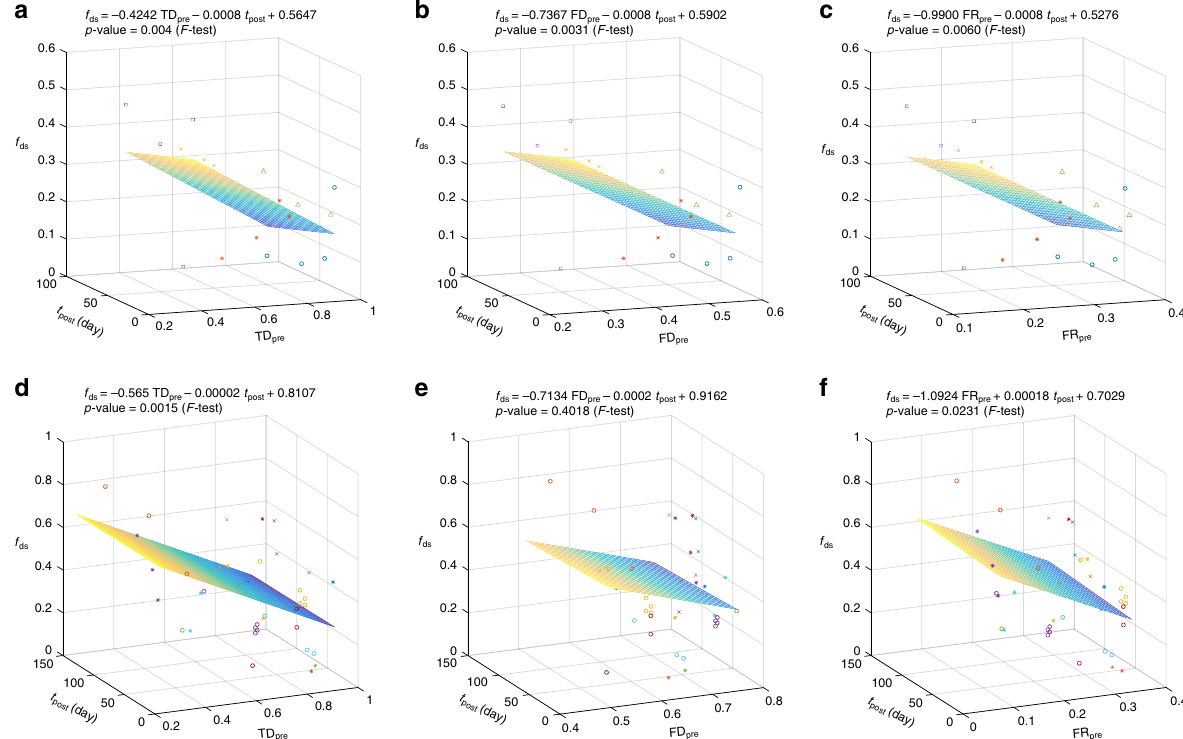
Fig. 5 Functional redundancy of recipient ’ s pre-FMT microbiota strongly affects the engraftment of donor microbiota. Analysis of two published FMT studies: a – c Li et al., Science (2016), where each of the fi ve patients with metabolic syndrome (represented by different symbols/colors) received a single FMT from one of three donors 44 ; d – f Smillie et al., Cell Host & Microbe (2018), where each of the 19 patients with recurrent C. dif fi cile infection (represented by different symbols/colors) were treated with FMT from one of four donors 45 . For each patient, we calculated: a , d the taxonomic diversity (TD) using the Gini-Simpson index; b , e the functional diversity (FD) using Rao ’ s quadratic entropy; and c , f the functional redundancy (FR = TD-FD) of his/ her pre-FMT gut microbiota, and the fraction of donor-speci fi c strains at different time points post-FMT. We then performed multiple linear regression of the fraction of donor-speci fi c strains as the response on TD (or FD, FR) of recipient ’ s pre-FMT microbiota and the days post-FMT as the predictors. P values were calculated from F